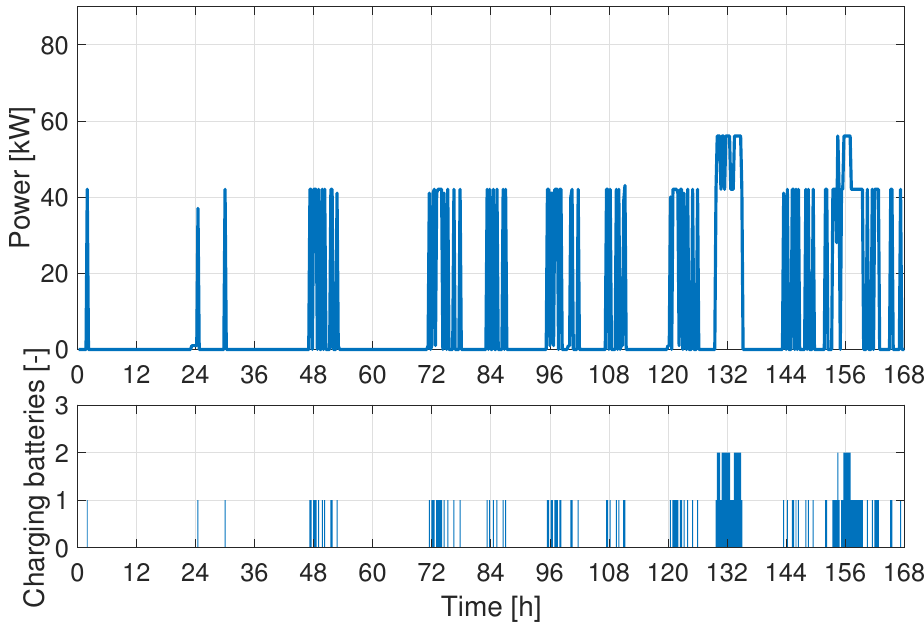
Figure 9. Power consumption (top) and battery charging schedule (bottom) at LIMB for the entire week